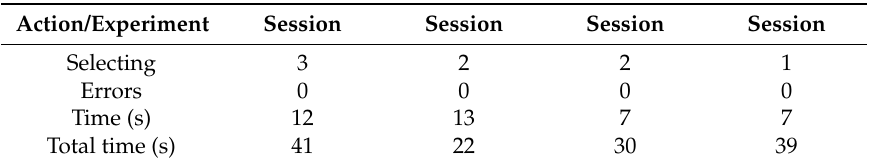
Table 2. Performance of User